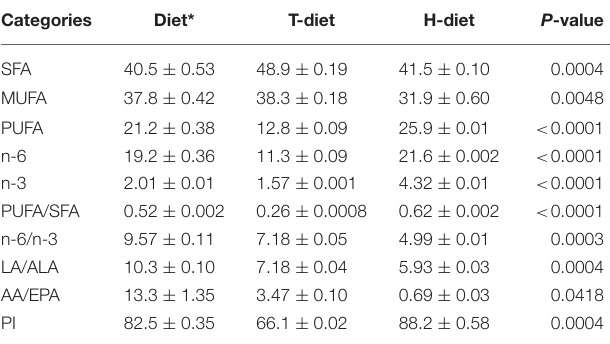
TABLE 3 | Categories of fatty acids (% of total fatty acids) of the administered diets.